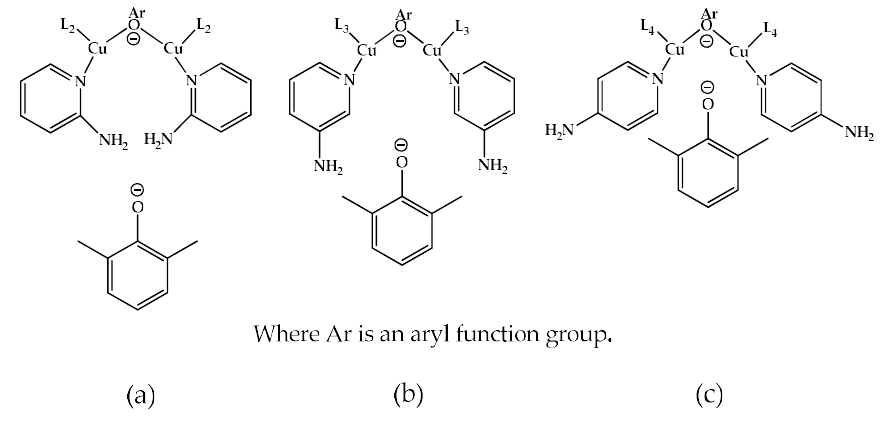
Figure 4. Steric environments of coordination compounds derived from L 2 , L 3 , or L 4 : ( a ) for L 2 , approach of the phenolate anion to the Cu ion is impossible due to strong steric hindrance (no polymerization); ( b ) for L 3 , approach of phenolate anion is possible due to reasonably relieved steric hindrance (polymerization occurs); ( c ) for L 4 , easy access of phenolate anion free from steric hindrance (fast polymerization occurs).